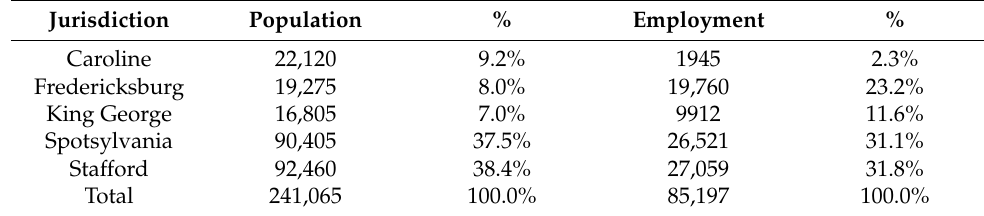
Table 1. FAMPO Region Population and Employment in 2000.